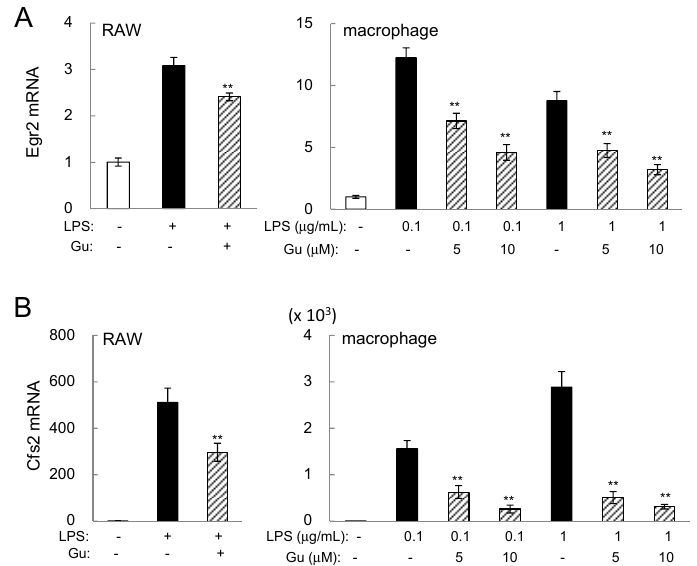
Figure 3. Guanabenz-driven downregulation of Egr2 and Csf2 (GM-CSF) in LPS-stimulated cells. The double asterisks indicate p < 0.01. ( A ) Egr2 mRNA levels in LPS stimulated RAW264.7 cells and primary macrophages in response to 5 or 10 µM guanabenz; ( B ) Cfs2 mRNA levels in LPS stimulated RAW264.7 cells and primary macrophages in response to 5 or 10 µ M guanabenz.